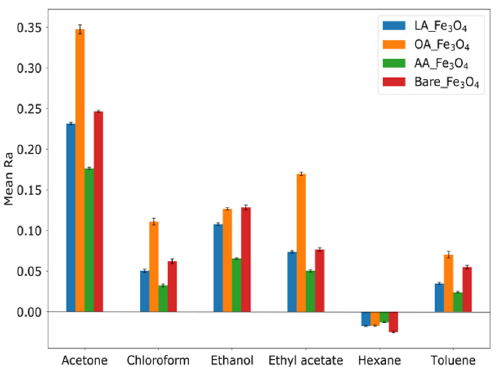
Figure 6. Responses of set B sensors upon 10 cycles of exposure to VOCs.